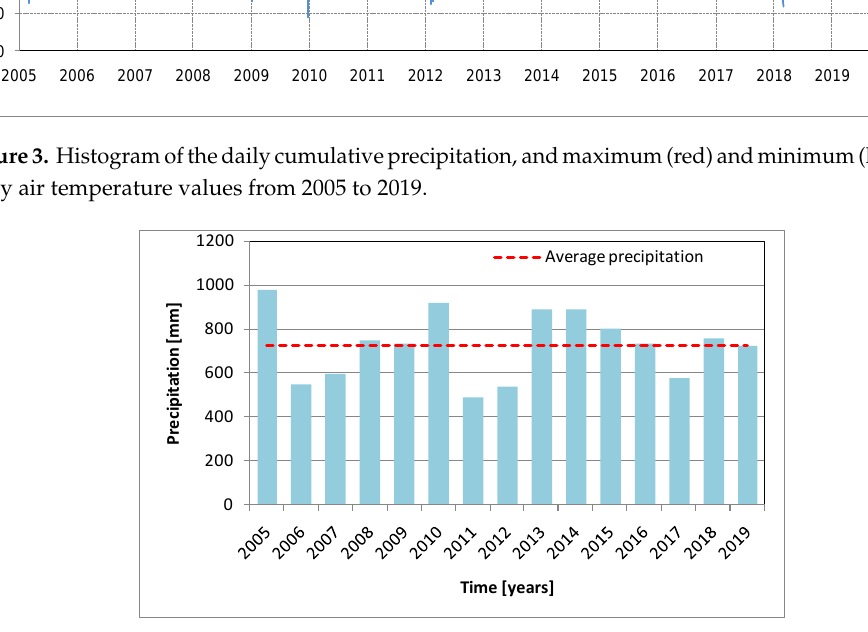
Figure 4. Histogram of the annual precipitation (light blue) and average value (red line) from 2005 to 2019.